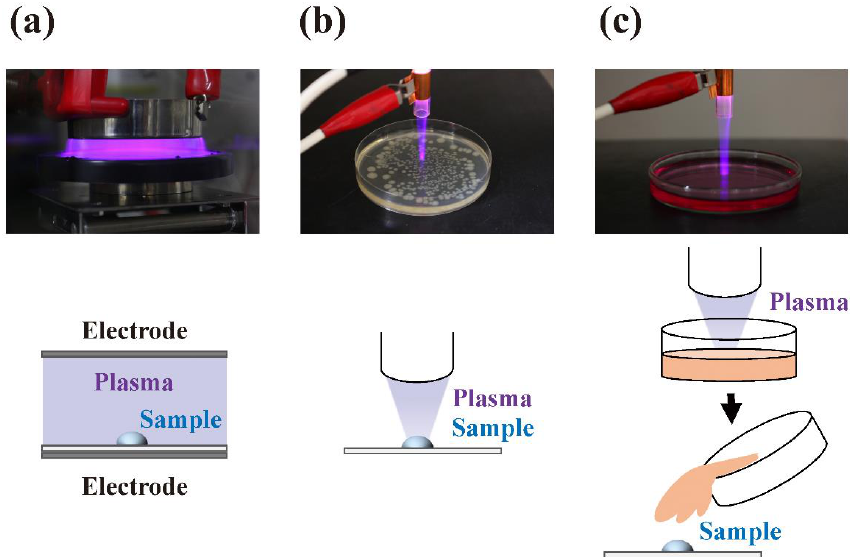
Figure 1. Types of plasma treatment can be classified as follows. ( a ) Discharging area is in contact with the sample, or ( b ) the sample is in contact with plasma transferred to the target site from the discharging area. Alternatively, ( c ) solutions previously subjected to plasma treatment could be used as reagents to apply to samples. Photographic images of the different modes of treatment are shown in the upper section with corresponding illustrations in the lower